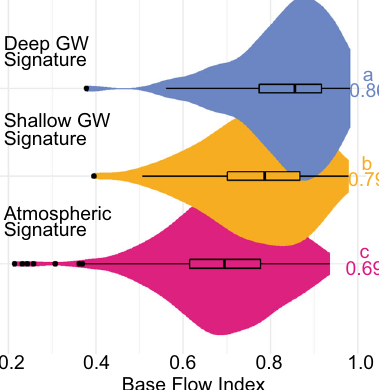
Fig. 2 Categorical groundwater (GW) signatures compared to base fl ow index (BFI). Letters indicate signi fi cance at p < 0.05 reported alongside median BFI. Counts of each category are atmospheric signature (pink) n = 401; shallow groundwater GW signature (yellow) n = 71; deep groundwater GW signature (blue) n = 82. Boxplots center line is the median and box limits are the upper and lower